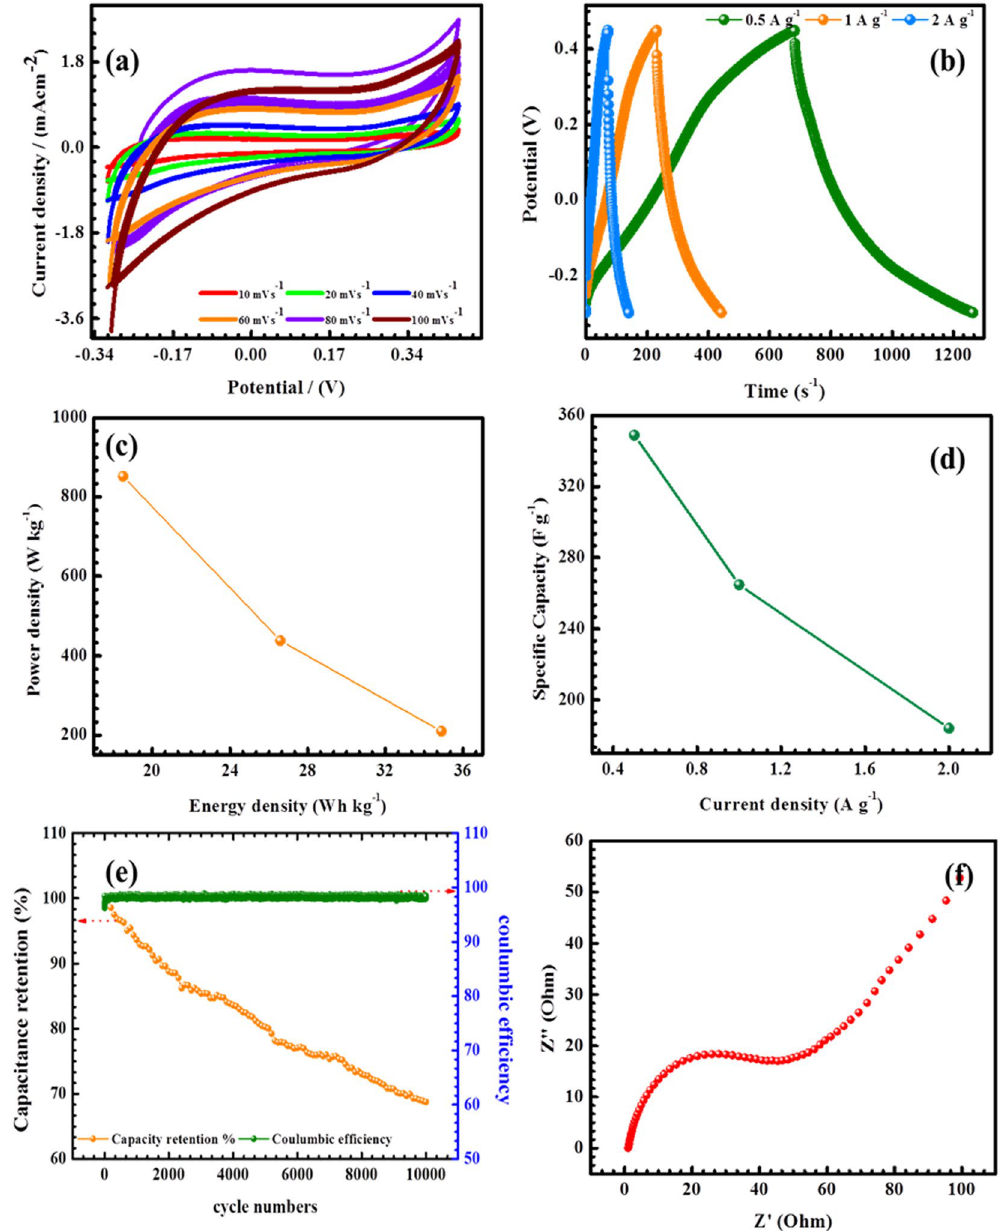
Figure 7. ( a ) CV plots of the Co 3 O 4 @MnO 2 /NGO at different scan rates in the range between 10 to100 mV s − 1 , ( b ) Galvanostatic charge-discharge behavior of the Co 3 O 4 @MnO 2 /NGO at various current densities, ( c ) Specific capacitance vs Current density plot, ( d ) Power density as function of energy density ( e ) Capacity retention plot for 10000 cycles ( f ) Nyquist impedance plot of the cell at ambient